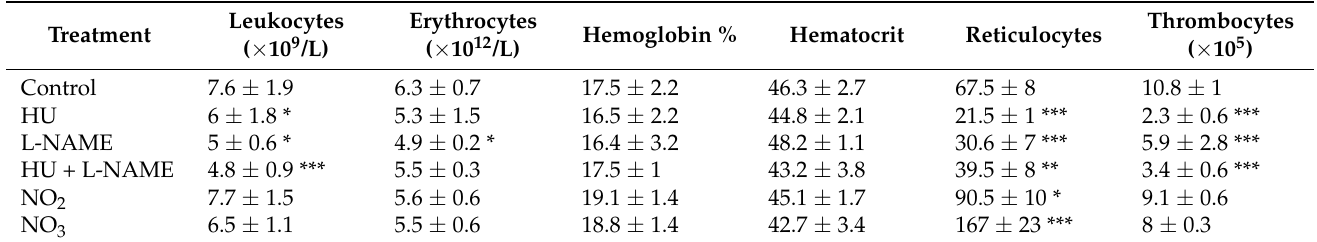
Table 1. Hematologic parameters in peripheral blood of treated mice.